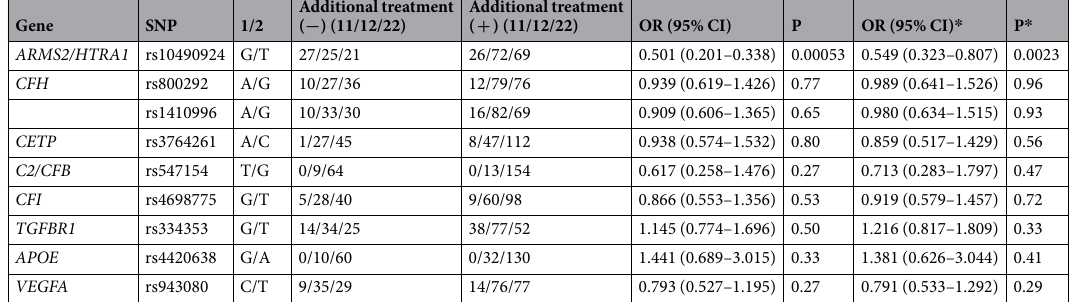
Table 1. Associations of 9 single-nucleotide polymorphisms in 8 age-related macular degeneration susceptibility genes with an additional treatment requirement after 3 monthly injections of ranibizumab in the discovery stage. * Adjusted for age and sex, SNP: single-nucleotide polymorphism, OR: odds ratio, CI: confidence interval.